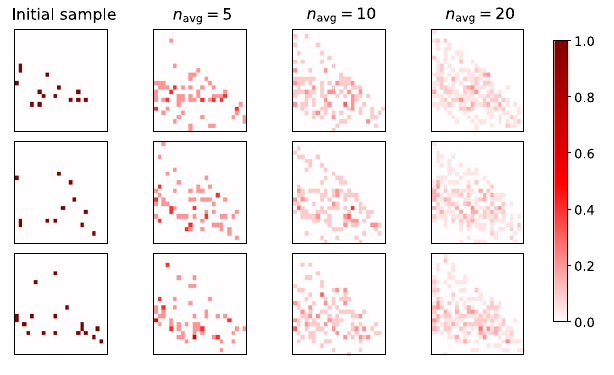
Fig. 2 Sample input images after averaging with n avg = 1 , 5 , 10 and